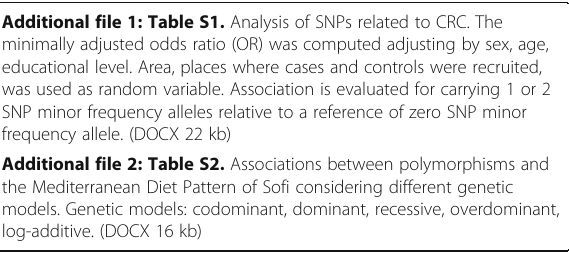
Abbreviations CESNID: Centre for Higher Studies in Nutrition and Dietetics; CRC: Colorectal cancer; FFQ: Spanish Food Frequency